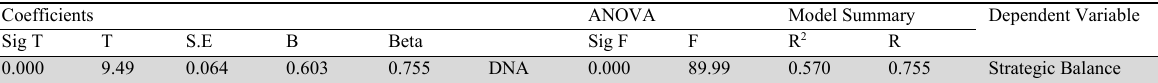
The results of the simple regression analysis for exploring the impact of Organizational DNA on strategic balance in com- mercial banks in Madaba